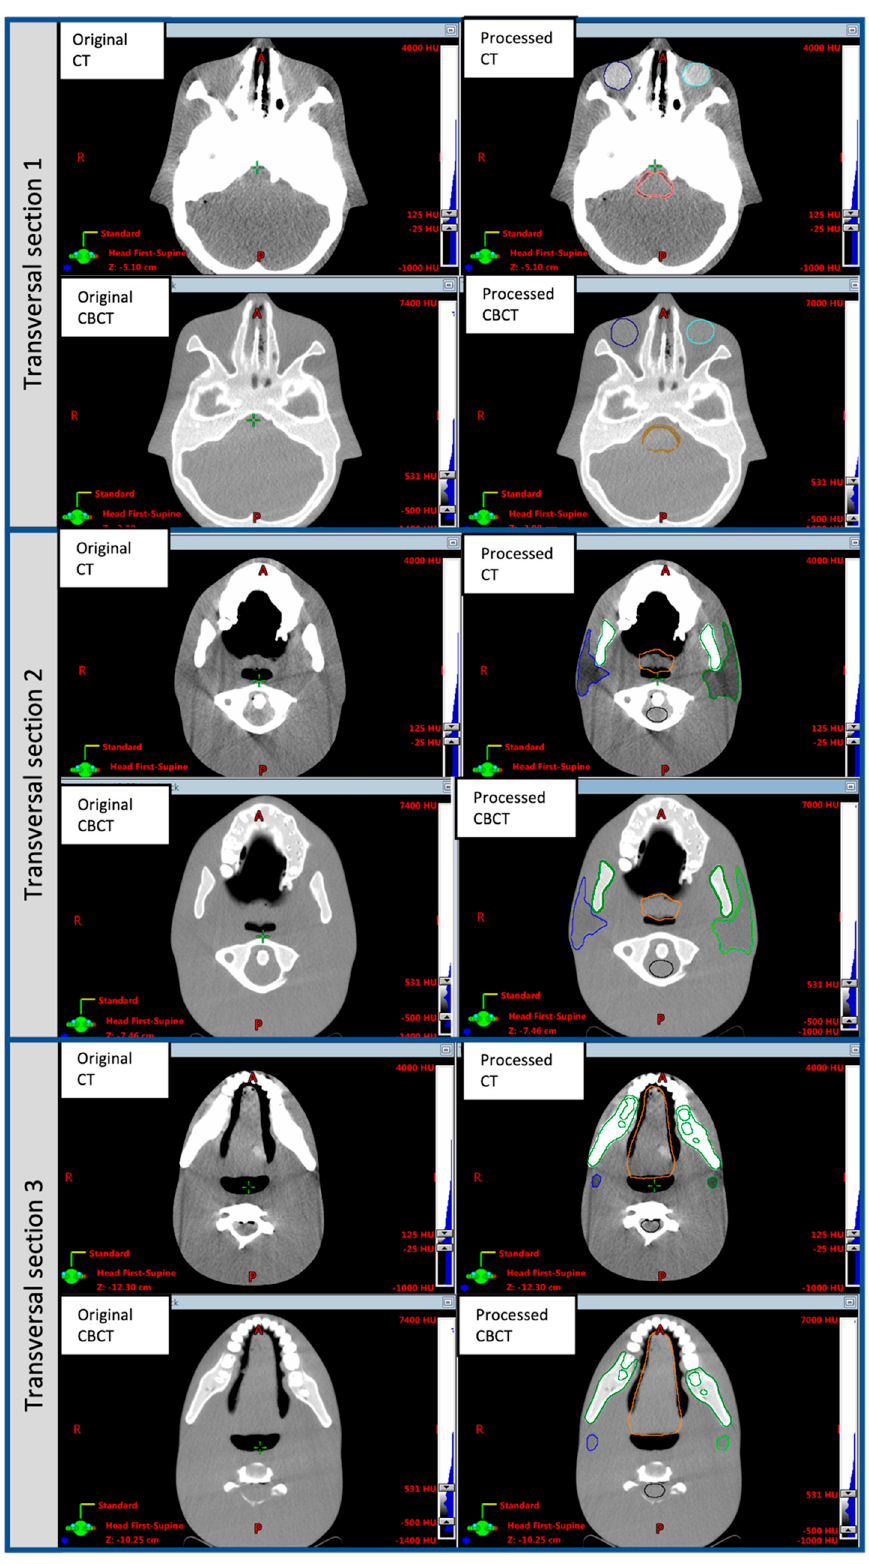
Figure 2. Original and post-processed CT and CBCT transverse sections of the CIRS ATOM Max Dental and Diagnostic Head Phantom Model-711 used in the method presented for DIR accuracy evaluation. Sections were chosen to visualize organs of interest. The HU values of parotid glands, larynx, oral cavity, brainstem and eyes were digitally modified using MATLAB and CERR tools, as described in Section 2.1.